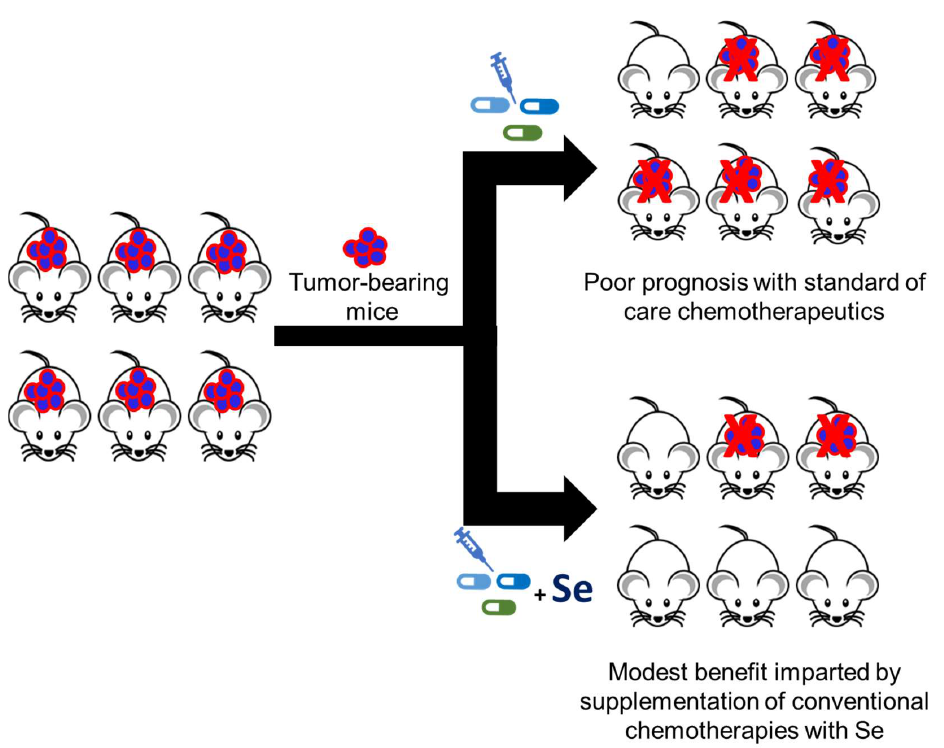
Figure 4. Standard cancer therapy administered in conjunction with selenium may exhibit improved efficacy in tumor-bearing murine models. efficacy in tumor-bearing murine